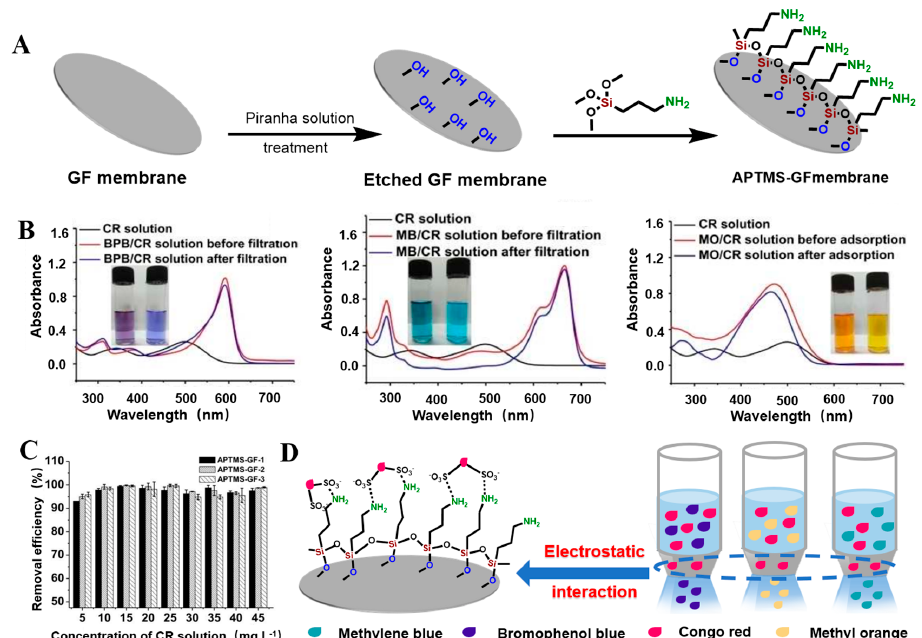
Figure 12. ( A ) Fabrication of the APTMS − GF composite membrane. ( B ) The UV − vis spectra of mixed dye solutions before and after filtration by the APTMS − GF membrane. ( C ) Removal efficiencies of a set of CR solutions with varied concentrations by APTMS − GF − 1 membrane, APTMS– GF − 2 membrane, and APTMS − GF − 3 membrane, respectively. Reproduced with permission from reference [109]. Copyright 2018 ChemistrySelect . ( D ) Schematic of the proposed separation mechanism on the APTMS–GF composite membrane.